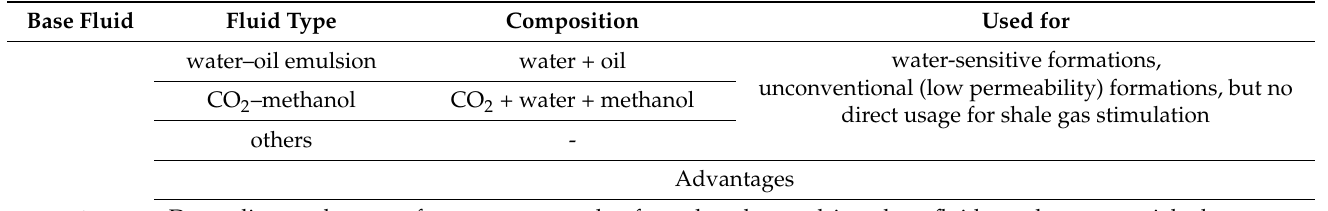
Table 9. Emulsion-based fracturing